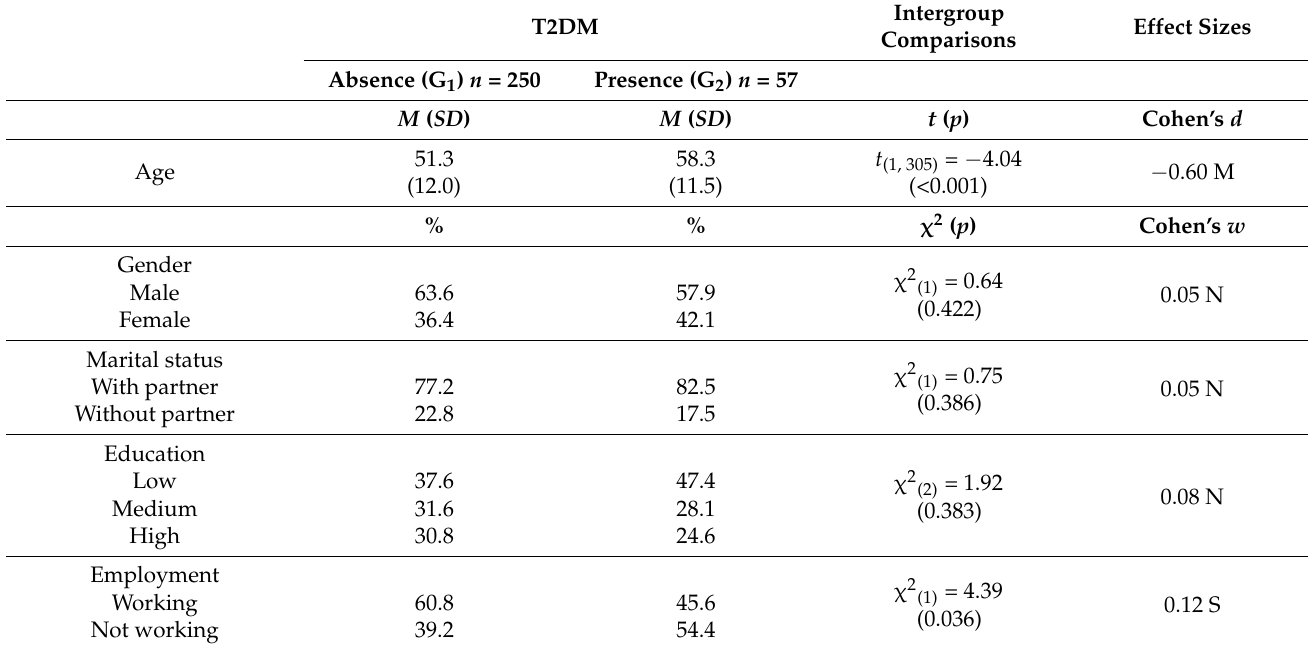
Table 1. Intergroup Comparison of Sociodemographic Variables: Type 2 Diabetes Mellitus (T2DM) (Absence and Presence) and Obesity (Absence and